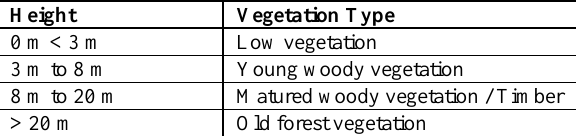
Table 2. Tree height classes (Ginzler et al.,